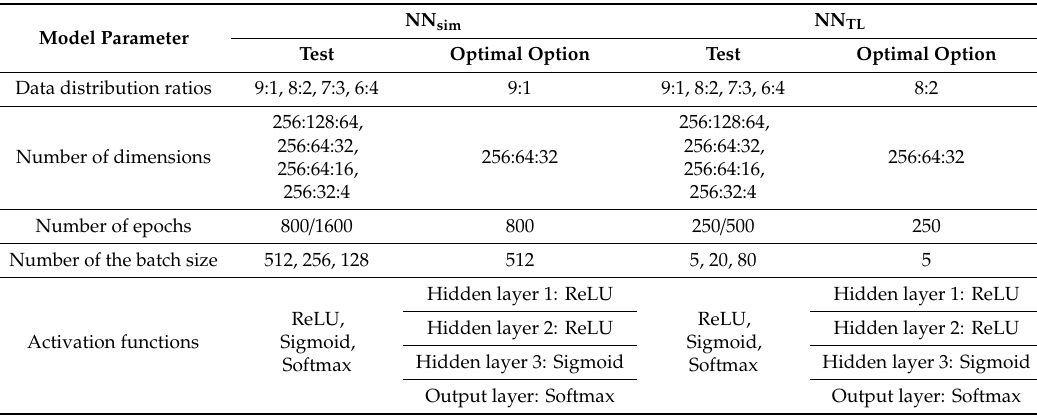
Figure 3. Workflow of the transfer learning-based deep neural network (DNN) for phytoplankton species composition inversion. Table 3. Model parameter adjustment test and optimal options.